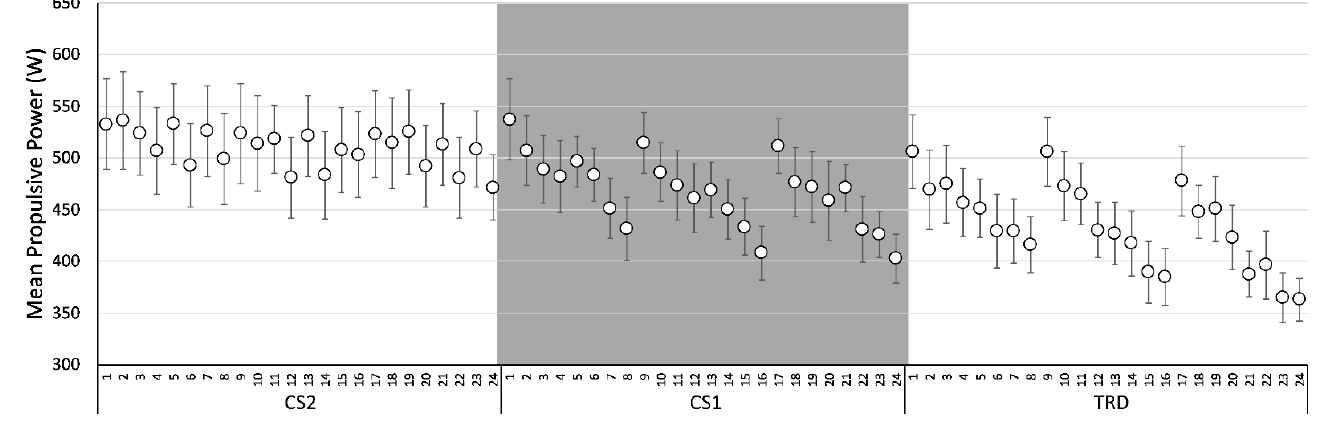
Figure 5. Mean Propulsive Power for Protocols CS2 (Cluster 2), CS1 (Cluster 1), and TRD (Traditional). Data are expressed as mean values and standard error.